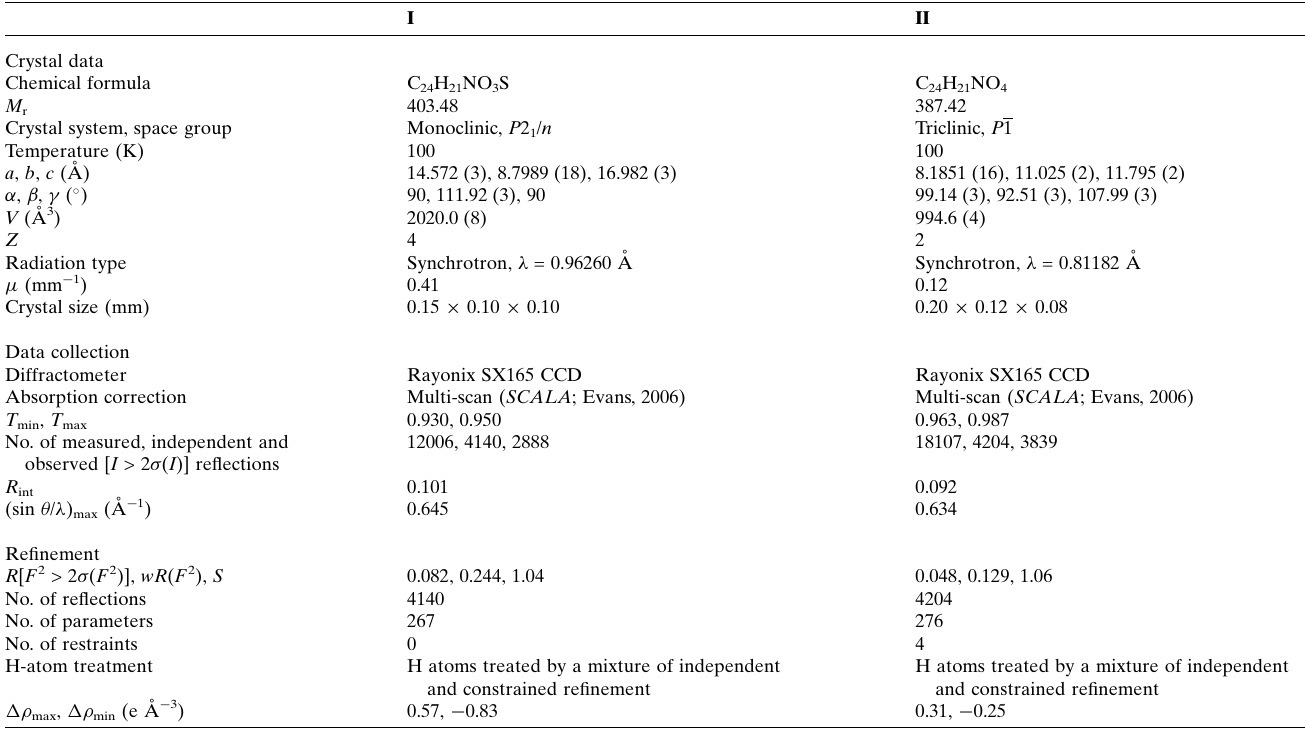
Table 3 Experimental details.